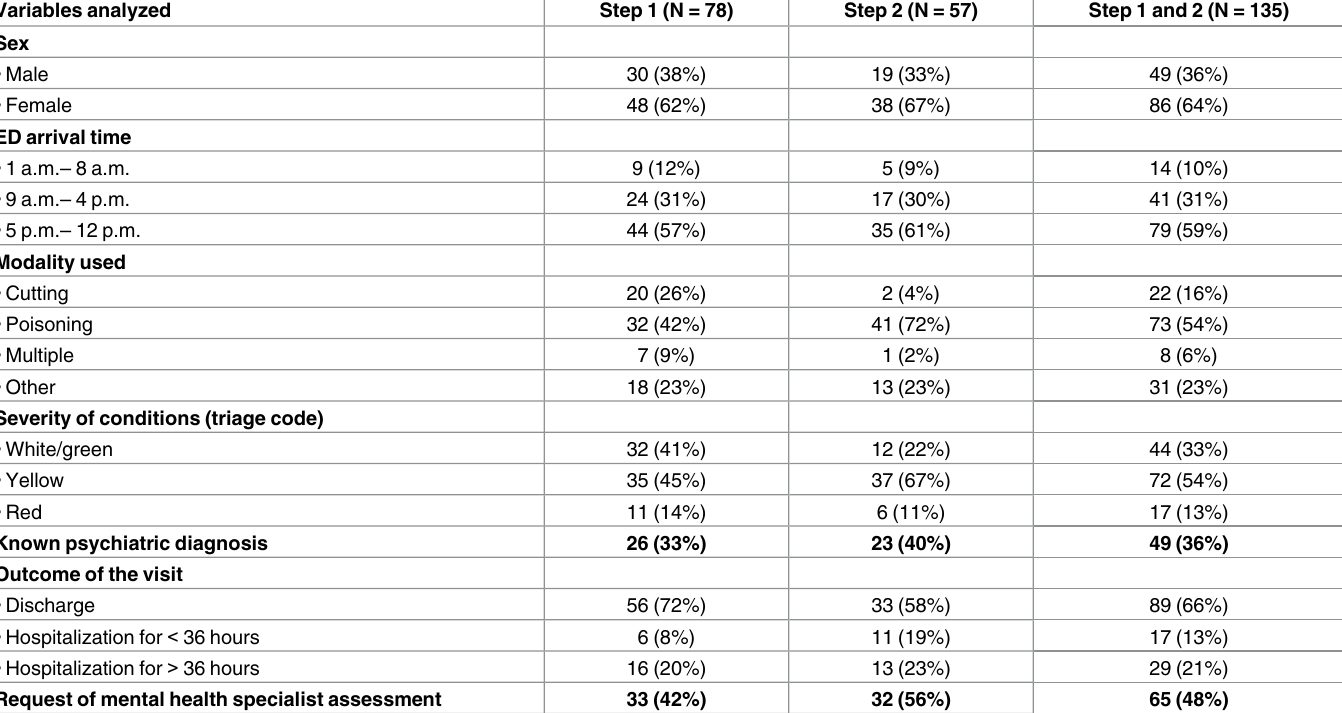
Table 2. Characteristics of SITBs among the cases visited at the EDs in the years2005 and 2006. Variables